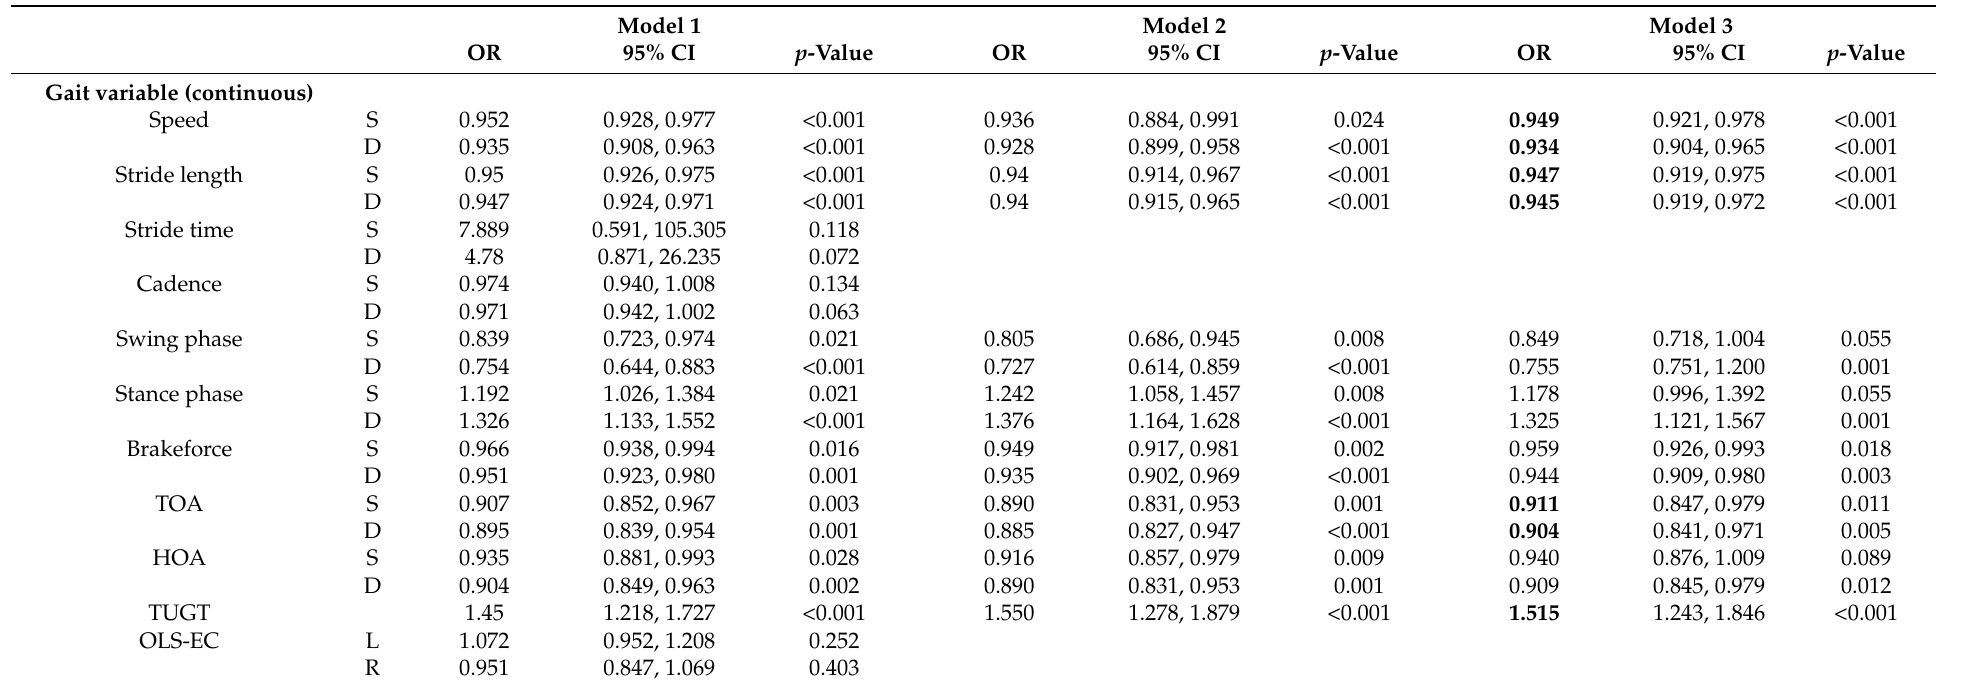
Table 3. Univariate and multivariate logistic regression models evaluating the associations of gait indicators with cognitive impairment.